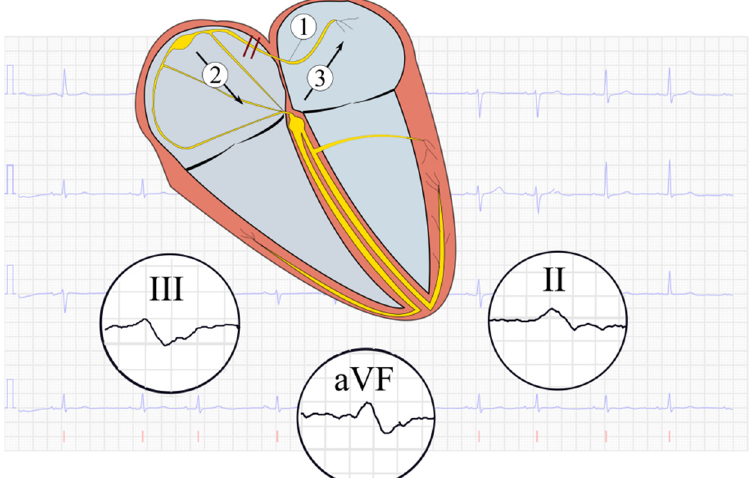
Figure 1. Description of the atrial depolarization route in advanced interatrial block with zoomed images of the P waves in inferior leads (II, aVF and III), in the case of a block in Bachmann’s bundle (1). Normally, depolarization of the atria travels through the right and left atria through internodal tracts, e.g., Bachmann’s bundle. Since impulse propagation from the right atrium to the left atrium is blocked, the right atrium will be depolarized first (2) followed by a retrograde depolarization of the left atrium (3), resulting in biphasic P waves in inferior leads. Modified from [10], reprinted with permission.